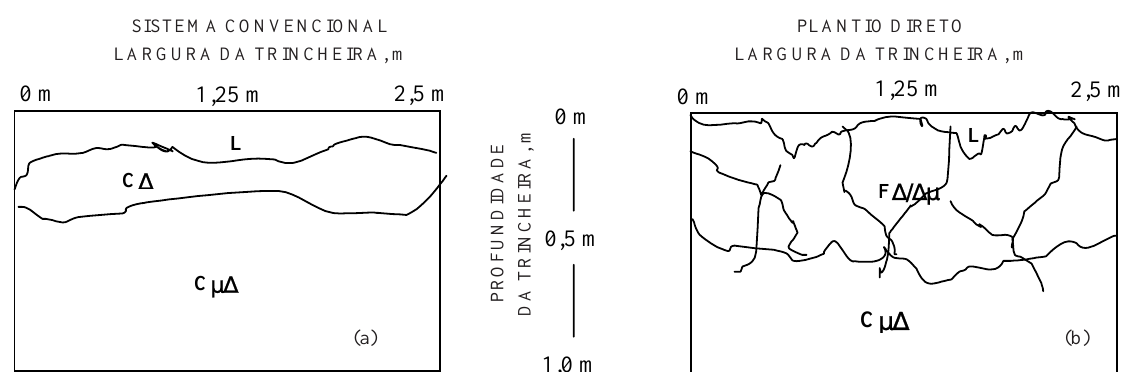
Figura 2. Representação esquemática das diferentes organizações dos perfis culturais, sob sistema convencional (a) e plantio direto (b) em Latossolo Roxo. Legenda: L- Volume de solo livre, poroso, constituído de solo pulverizado e torrões de tamanho variados; C DDDDD - Volume de solo homogêneo (C), formado por torrões compactos ( DDDDD ), sem porosidade visível; F DDDDD / DDDDD µ- Volume de solo fissurado (F), com porosidade fissural visível, formado por torrões compactos ( DDDDD ) e em processo de compactação ( DDDDD µ). Cµ DDDDD - Volume de solo homogêneo (C), formado por torrões (µ DDDDD ), porosos, com aspecto mais para não compacto (µ) do que compacto ( DD DD D